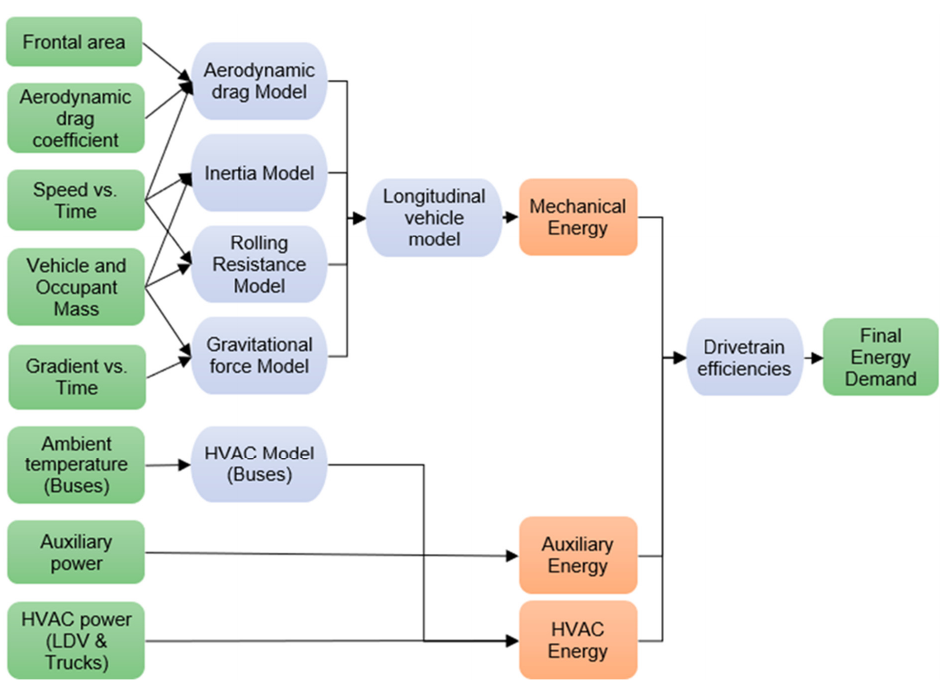
Figure 1. Structure of the model of the on-road transport mode energy demand.